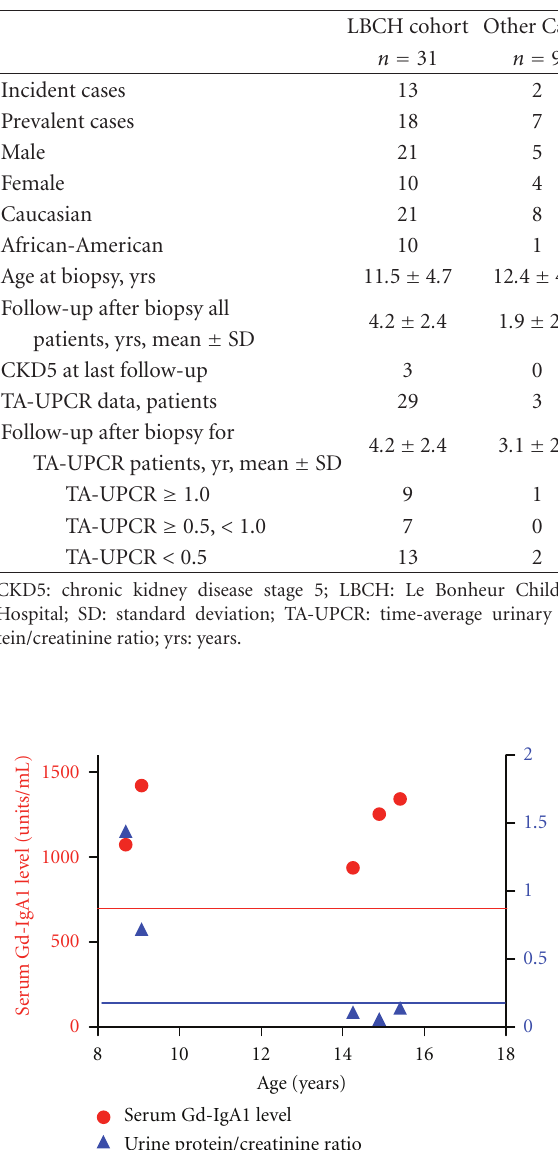
Table 3: Clinical and demographic features of cohorts.